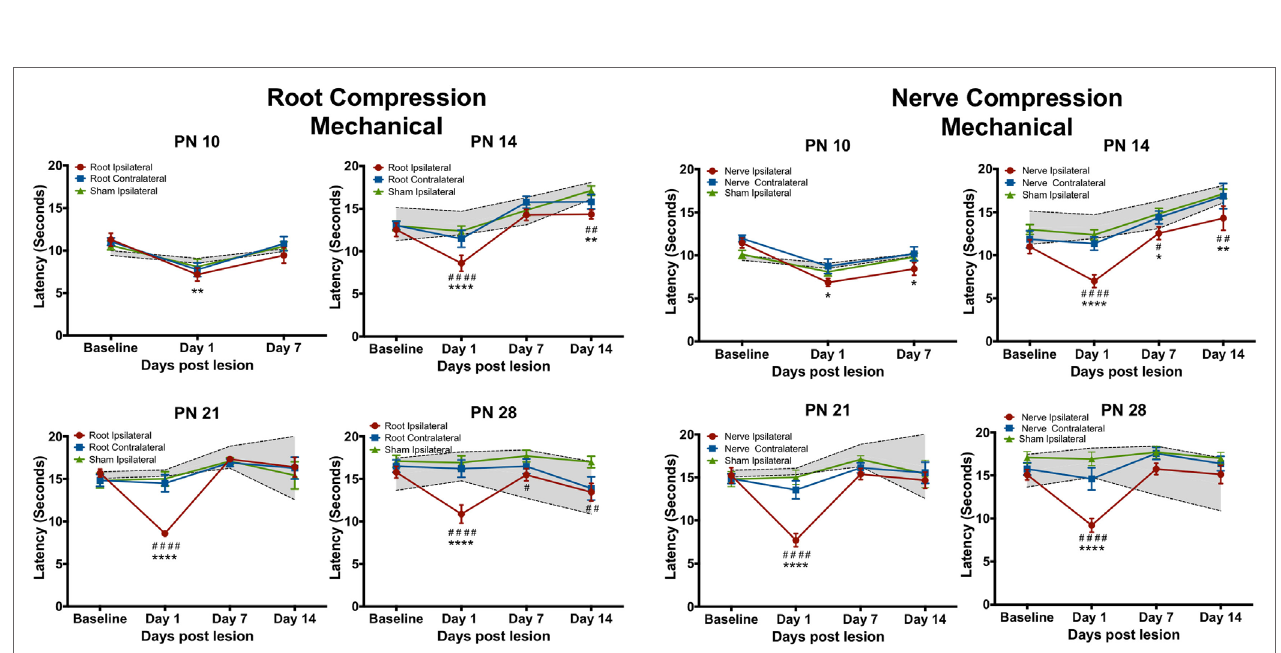
FigUre 2 | The change in the forepaw response to the thermal stimulus following root or nerve compression . The age of surgery is above each panel and the X -axis denotes the time of testing postsurgery. The 95% confidence intervals for the naïve controls are denoted by the shaded area between the dashed lines. Significant differences from the naïve subjects are denoted by * and from the forepaw ipsilateral to the sham surgery by #. N = 8 except PN14, N = 6. * /# p < 0.05; ** /## p < 0.01; *** /### p < 0.001; **** /#### p <